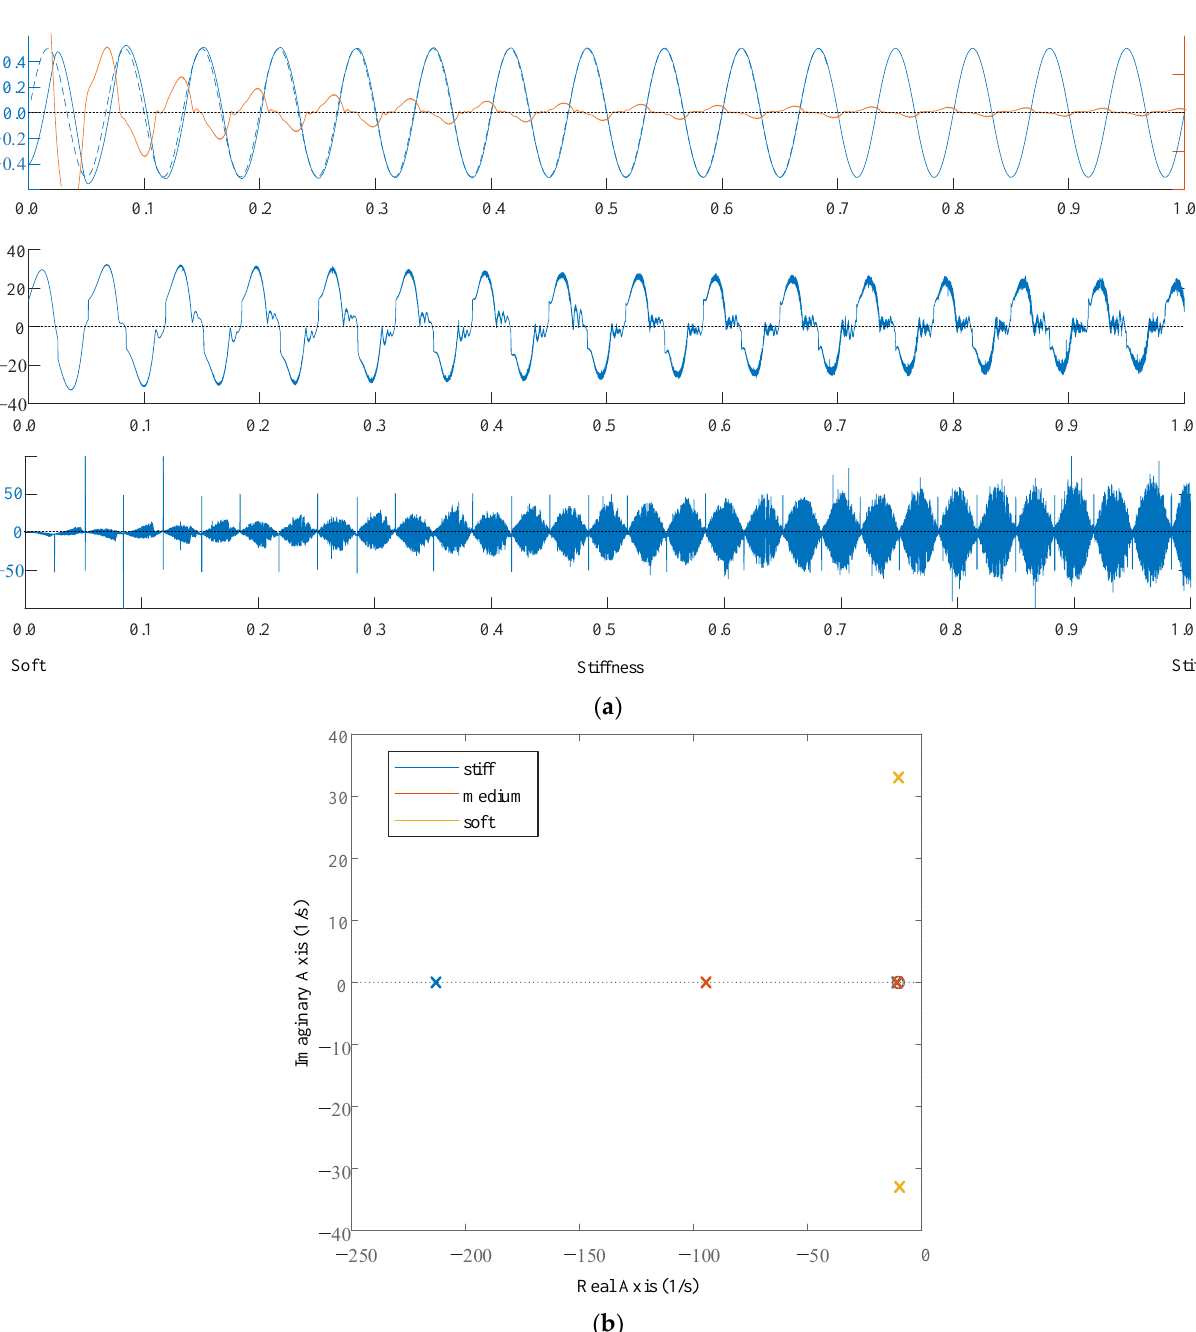
Figure 5. Effect of soft/stiff controller on the behavior of the closed − loop: experimental